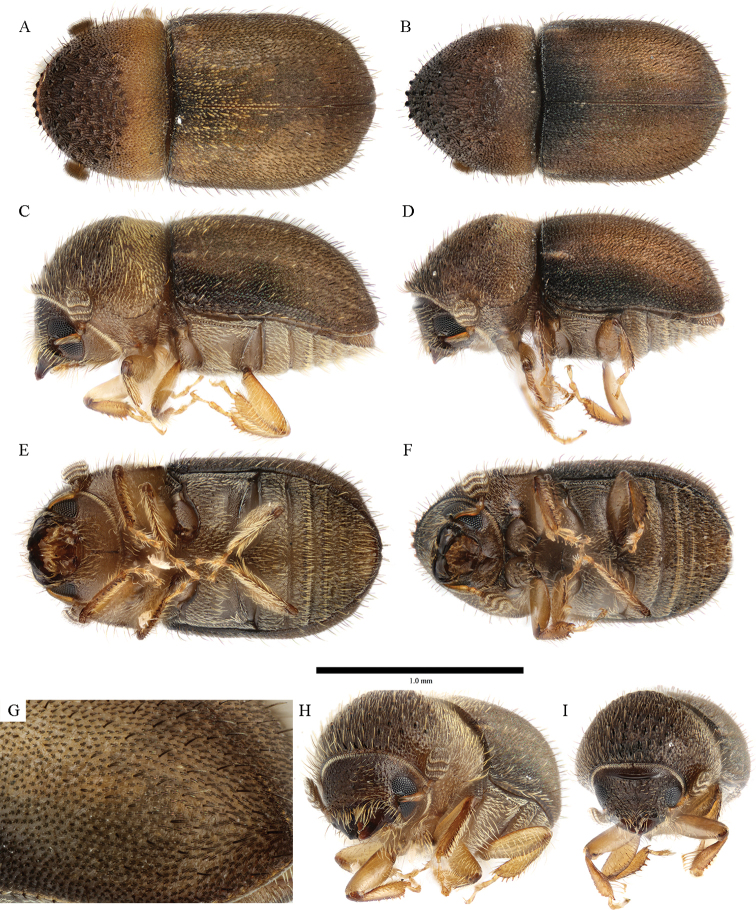
Cryphalus
itineransA, C, E, G, H holotype, female UFFE:33170 B, D, F, I paratype, male, UFFE:31746.